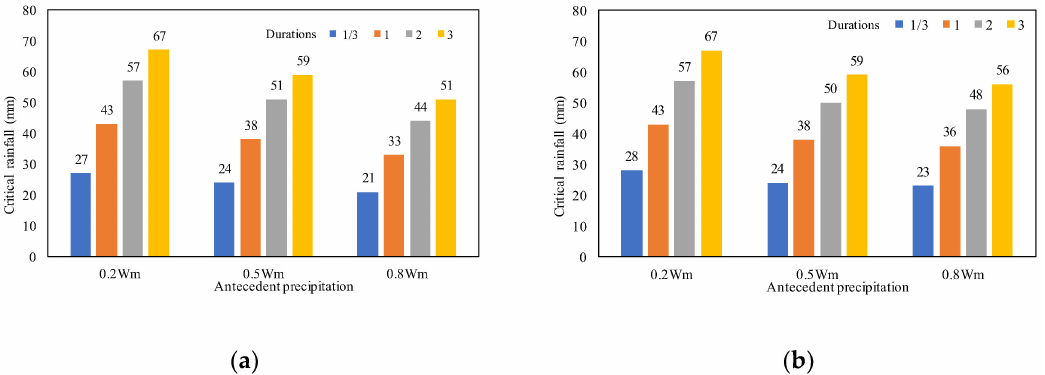
Figure 13. Critical rainfall/immediate migration index in rainfall with different antecedent precipitation values and durations (hours): Anding ( a ), Qiangjiawan ( b ).